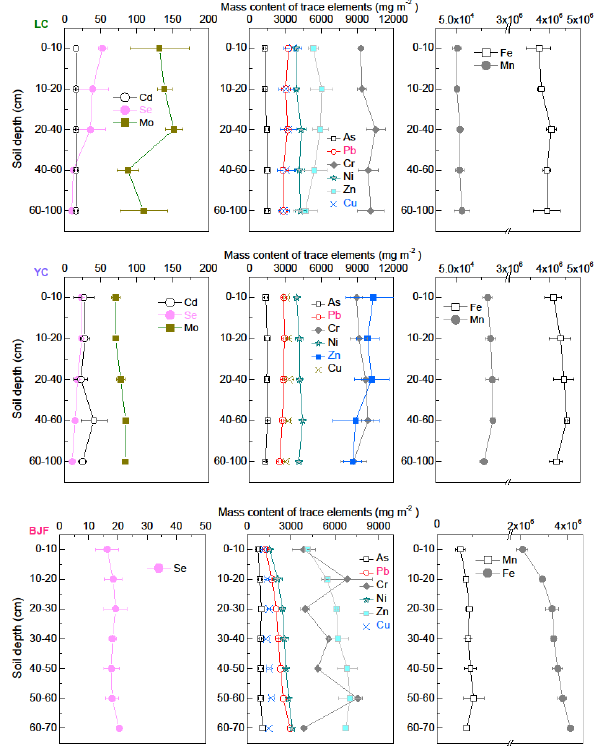
Figure 5. Soil profile of selected elements from three typical agri- cultural and forest sites in Northern